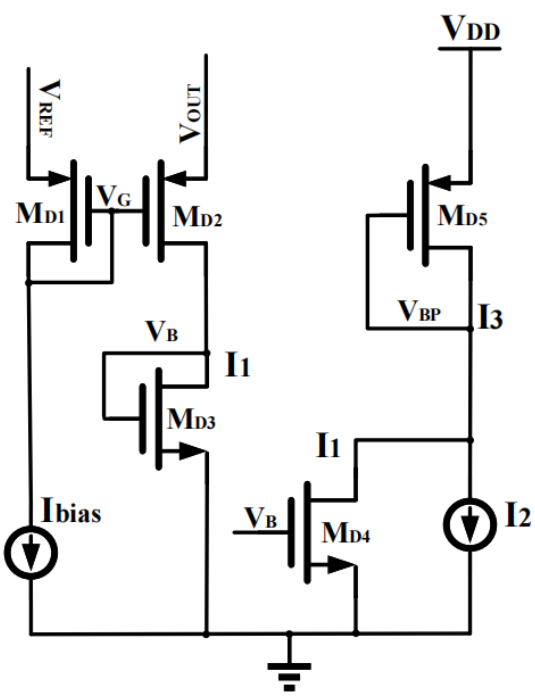
Figure 2. Structure of the proposed dynamic bias circuits.